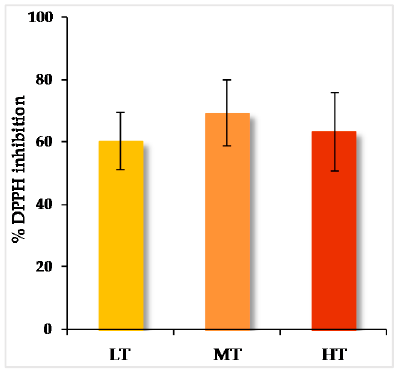
Figure 8. Mean values of antioxidant activity of the wine spirits aged in barrels with different toasting levels (LT—light toasting; MT—medium toasting; HT—heavy toasting). Adapted from [122].